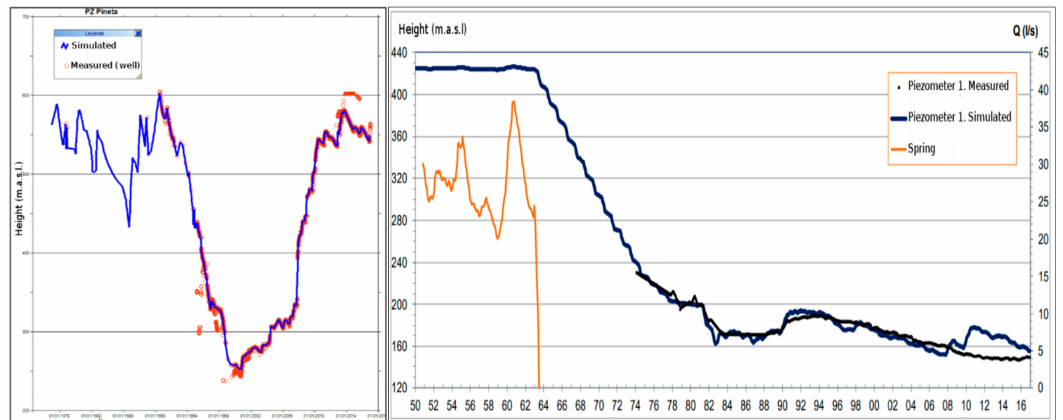
Figure 8. Simulated levels (continuous line) vs. observed levels (red dots) for some wells of the Orba aquifer in Alicante. From